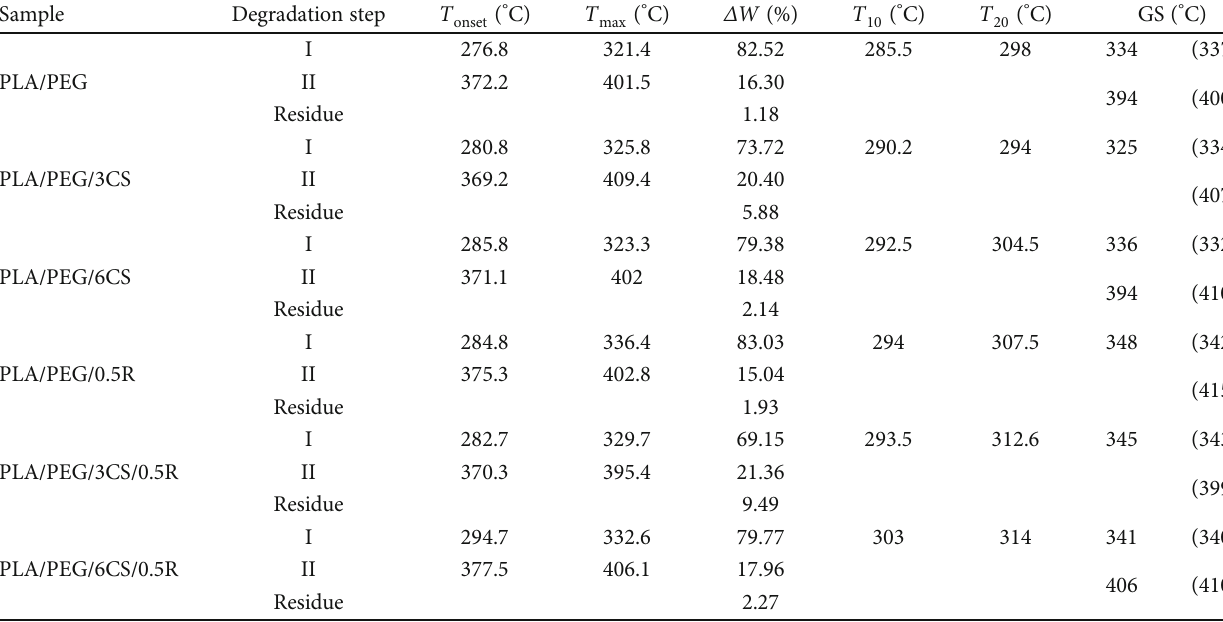
Table 3: TG data for PEG-plasticized PLA containing chitosan and powdered rosemary ethanolic extract.